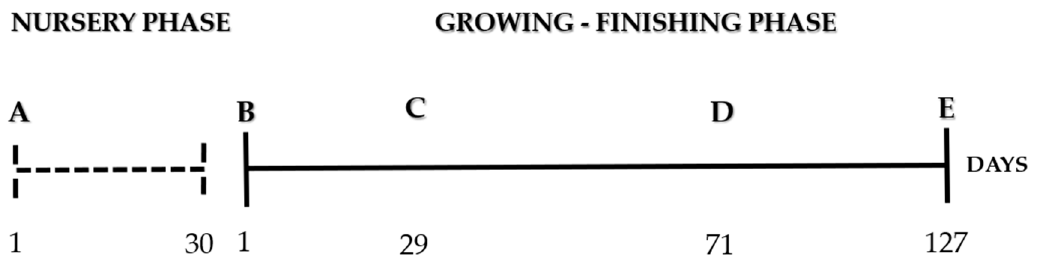
Figure 2. Experiment timeline. This study was conducted for 157 days according to this timeline sequence: A: nursery phase (30 days)—arrival of piglets at the institute facilities and adaptation period; B: growing–finishing phase (127 day)—beginning of the experimental period and first mix performed; C: female mix (second mix performed); D: barrow mix (third mix performed); E: end of the experimental period and pig slaughter.